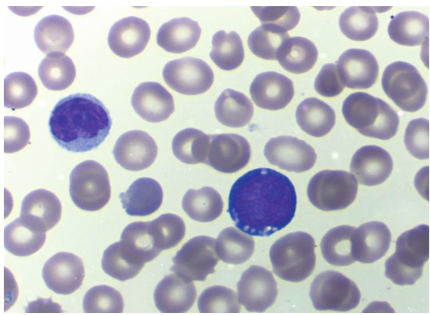
Figure 3: Peripheral smear, Wright-Giemsa stain, 100x image showing an abnormal circulating lymphoid cell with the same cytology as the lymphoid cells in the bone